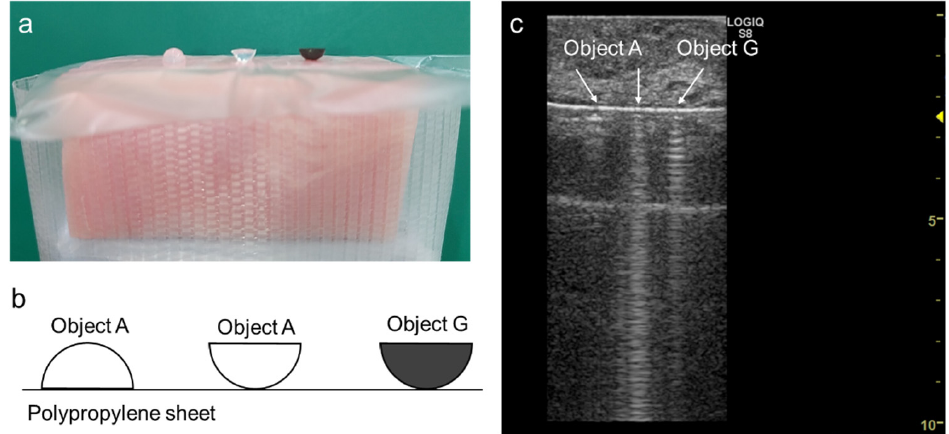
Figure 1. Photograph ( a ) and schematic representation ( b ) of the experimental system and an ultrasound image ( c ) obtained with the system. The object A on the left side generated a short vertical artifact. The object A on the right side generated a long vertical artifact without a qualitative attenuation according to the depth. The object G generated a vertical artifact which was visually attenuated on the deeper